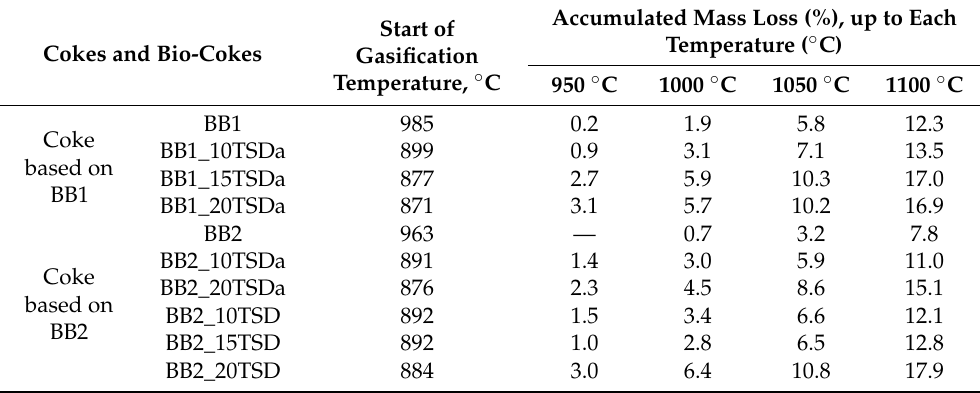
Table 5. Start of gasification temperatures and accumulated mass loss of laboratory-produced cokes up to different temperatures as measured in TGA.